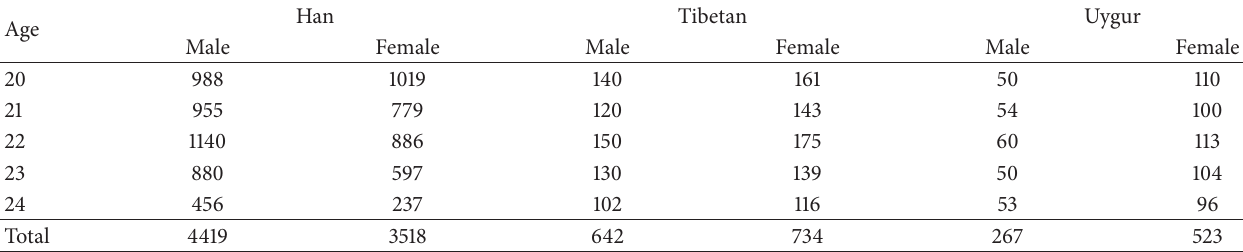
Table 1: Population distributions of Han, Tibetan, and Uygur university